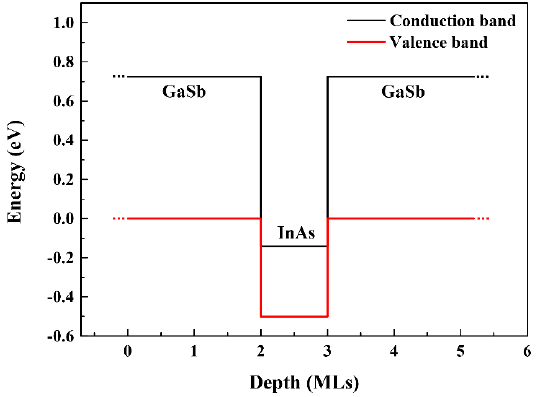
Figure 2. Schematic band diagram of a quantum − well with arbitrary well width.